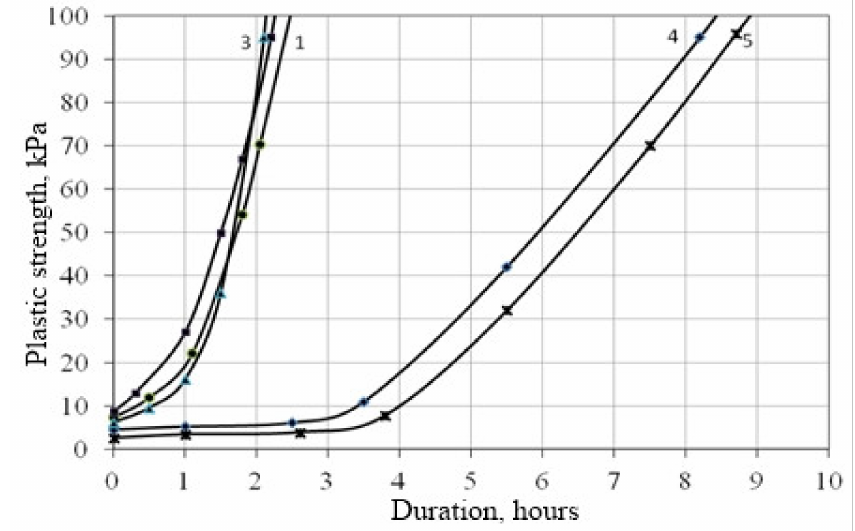
Figure 7. Change in the plastic strength of the lime specimens: 1—03A+S-3 superplasticizer; 2— 03B+SP-3 superplasticizer; 3—03A+Kratasol superplasticizer; 4—03C; 5—03D+S-3 superplasticizer.